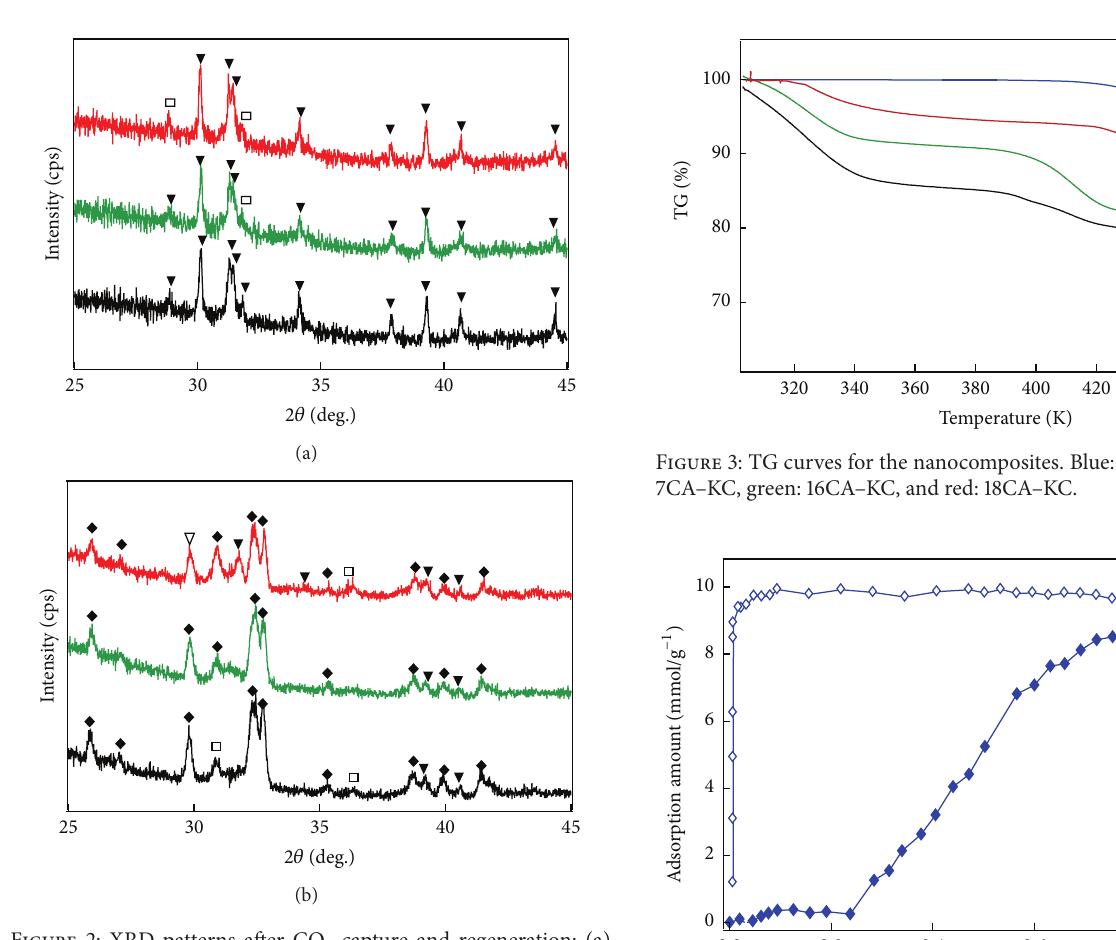
Figure 2: XRD patterns after CO 2 capture and regeneration: (a) x CA–KC nanocomposite after CO 2 capture under moist conditions; (b) x CA–KC nanocomposites placed under ambient atmosphere after being regenerated at 473 K for 2 h. Pore width: black, 7 nm; green, 16nm; red, 18 nm. 󳶃 : KHCO 3 , ◻ : K 4 H 2 (CO 3 ) 3 ⋅ 1.5H 2 O, 󳶚 : K 2 CO 3 , and X : K 2 CO 3 ⋅ 1.5H 2 O.